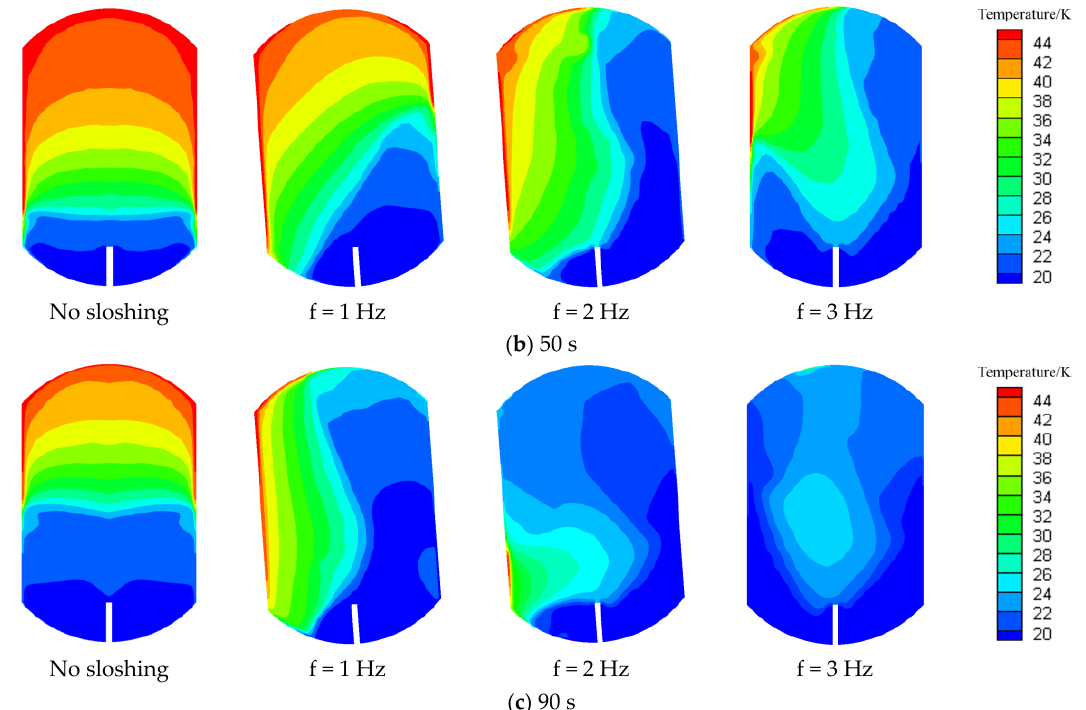
Figure 19. Graphic contours of temperature distribution under different sloshing and microgravity conditions at ( a ) 10 s, ( b ) 50 s, and ( c ) 90 s.